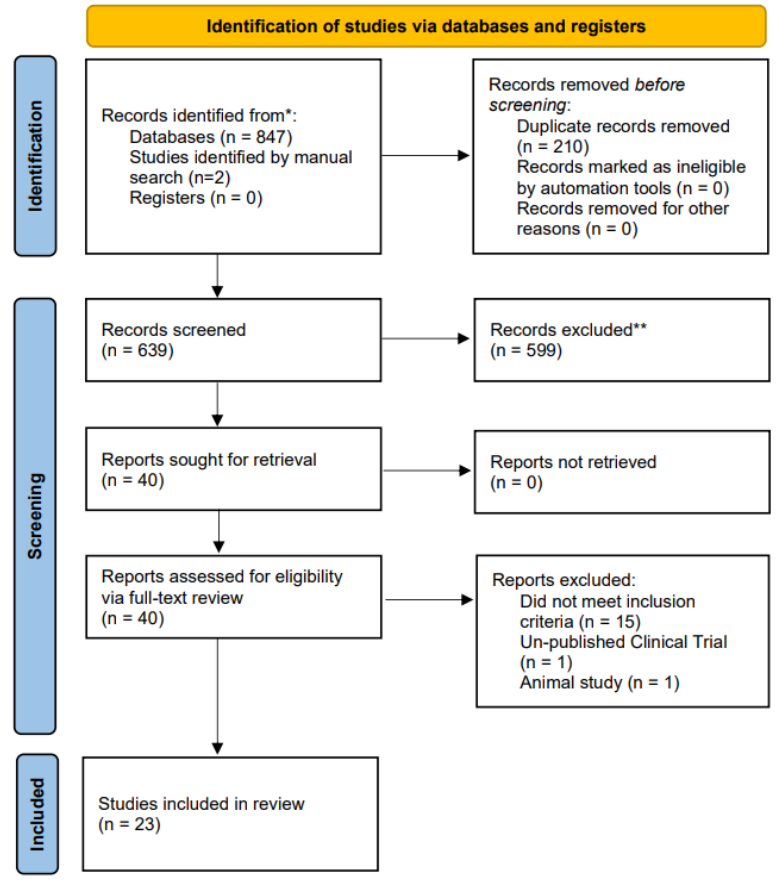
Figure 1. PRISMA flow diagram for systematic review. Flow chart of the study selection process, inclusion and exclusion of studies, and reasons for exclusion are displayed. * Databases included Ovid MEDLINE(R), Ovid EMBASE, Ovid Cochrane Central Register of Controlled Trials, Ovid Cochrane Database of Systematic Reviews, and Scopus. **Records excluded from title and abstract screening only.